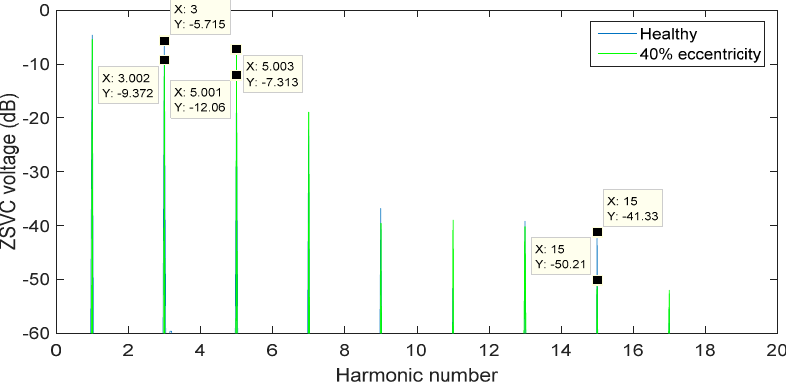
Figure 10. Low-current low-saturation operating conditions with a current angle of 30°. Spectral content of the ZSVC. Healthy machine and faulty machine with 40% eccentricity.